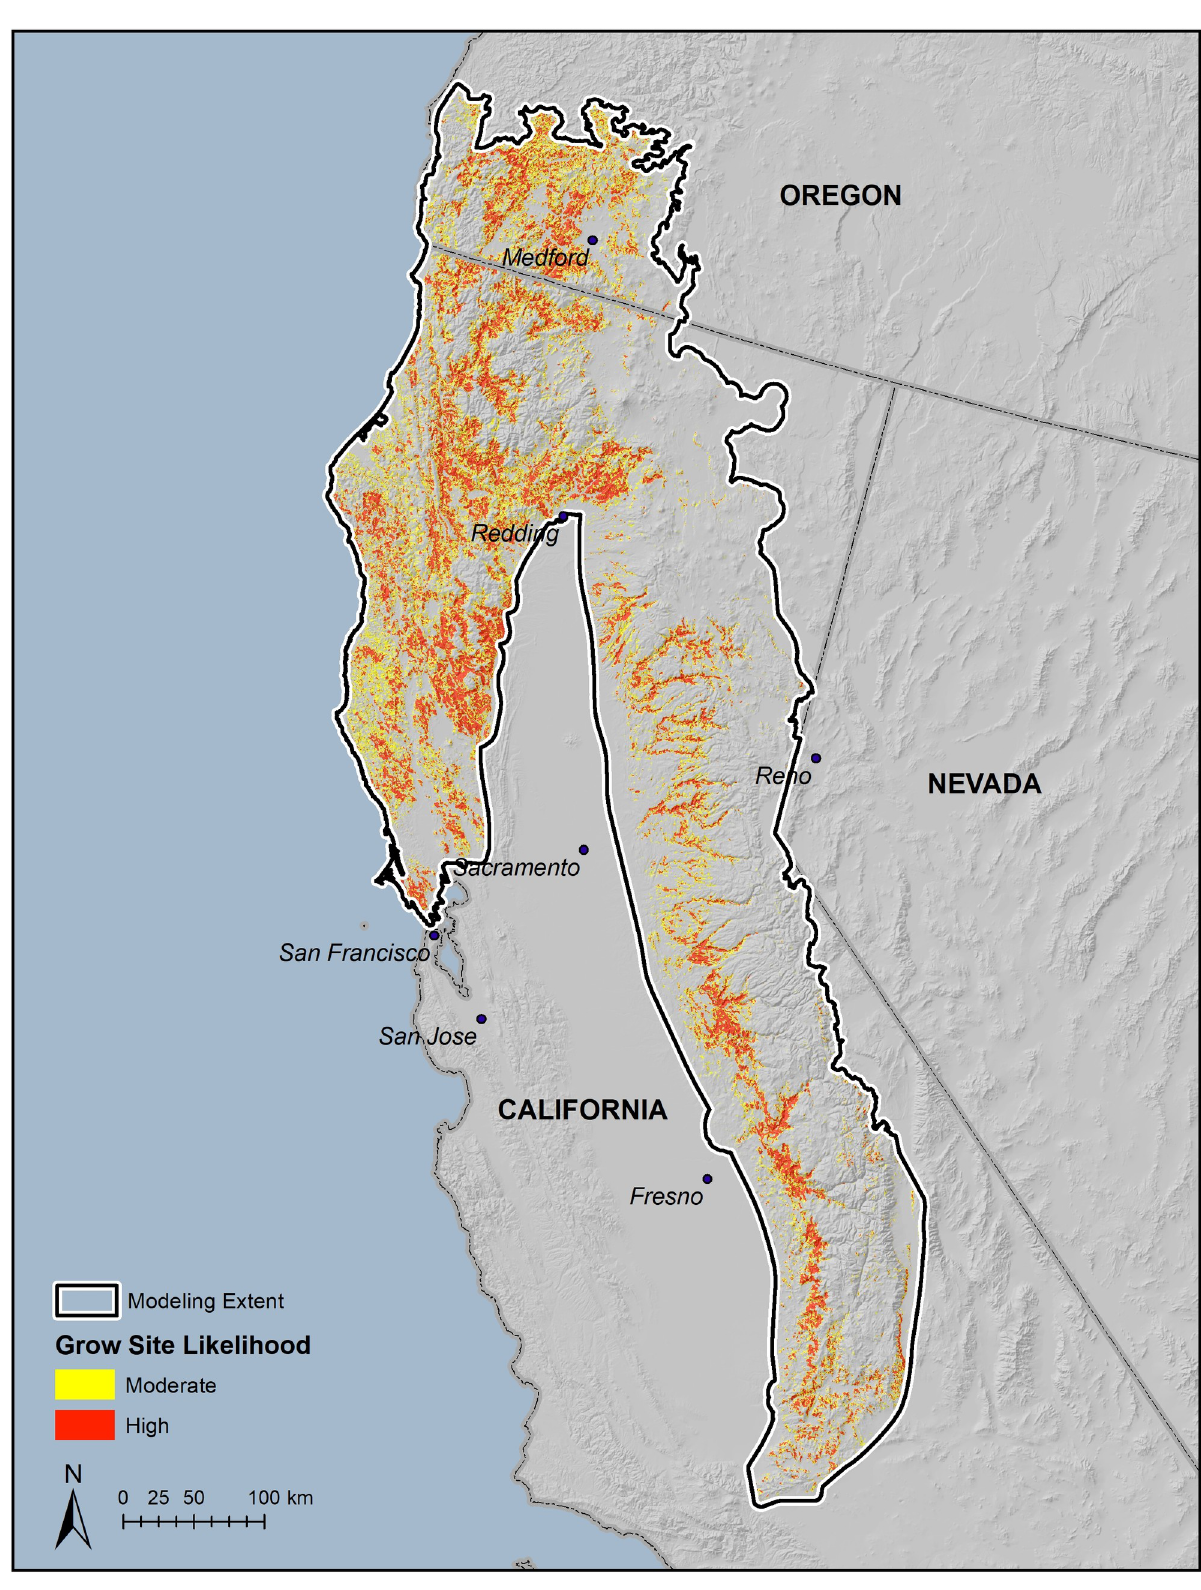
Fig 2. Modeled cannabis cultivation likelihood using MaxEnt and locality data from 2008–2014.